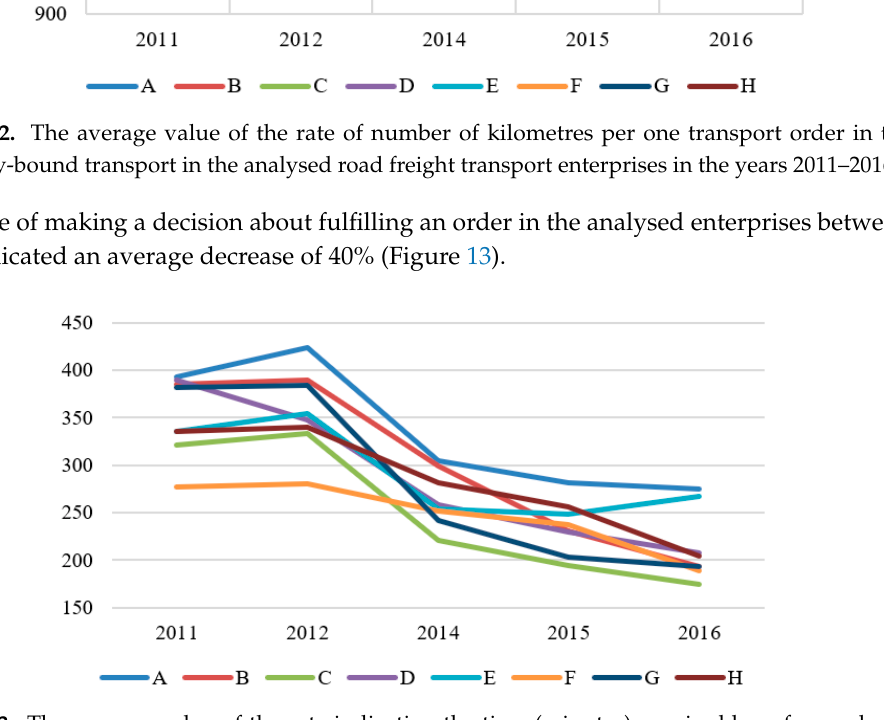
Figure 13. The average value of the rate indicating the time (minutes) required by a forwarder to make a decision about fulfilling an order in the Germany-bound transport in the analysed road freight transport enterprises in the years 2011–2016.